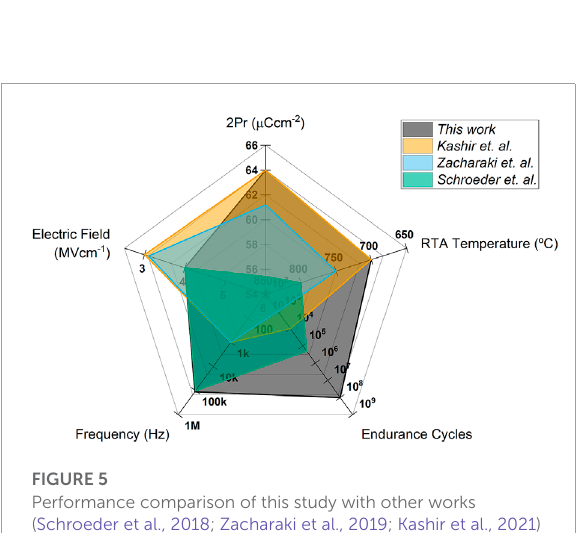
FIGURE 5 Performance comparison of this study with other works (Schroeder et al., 2018; Zacharaki et al., 2019; Kashir et al., 2021) with high 2P r .